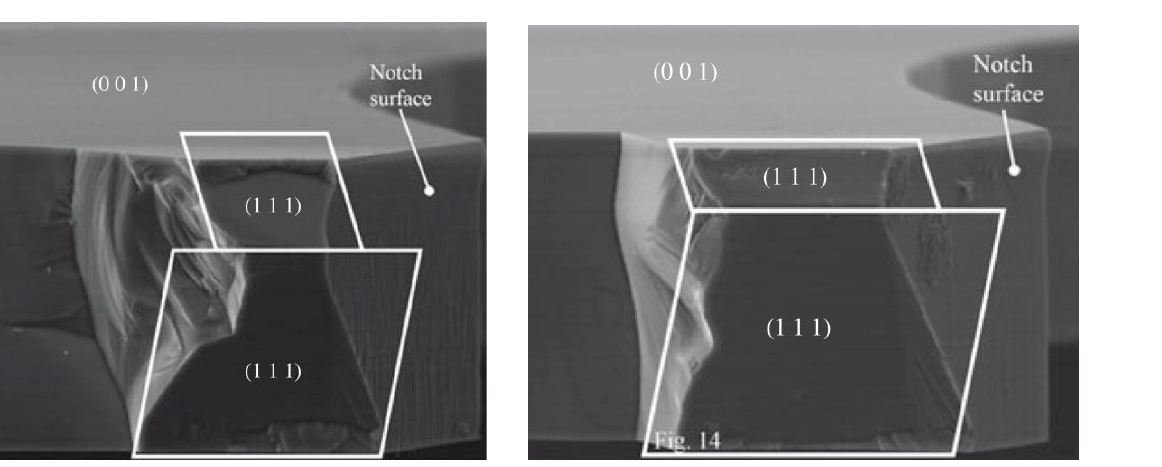
Figure 6. Post-mortem SEM images of the shock-induced failure mechanism in micro-beams, showing crack surfaces aligned with {111} crystal planes, after [26] (© [2008]